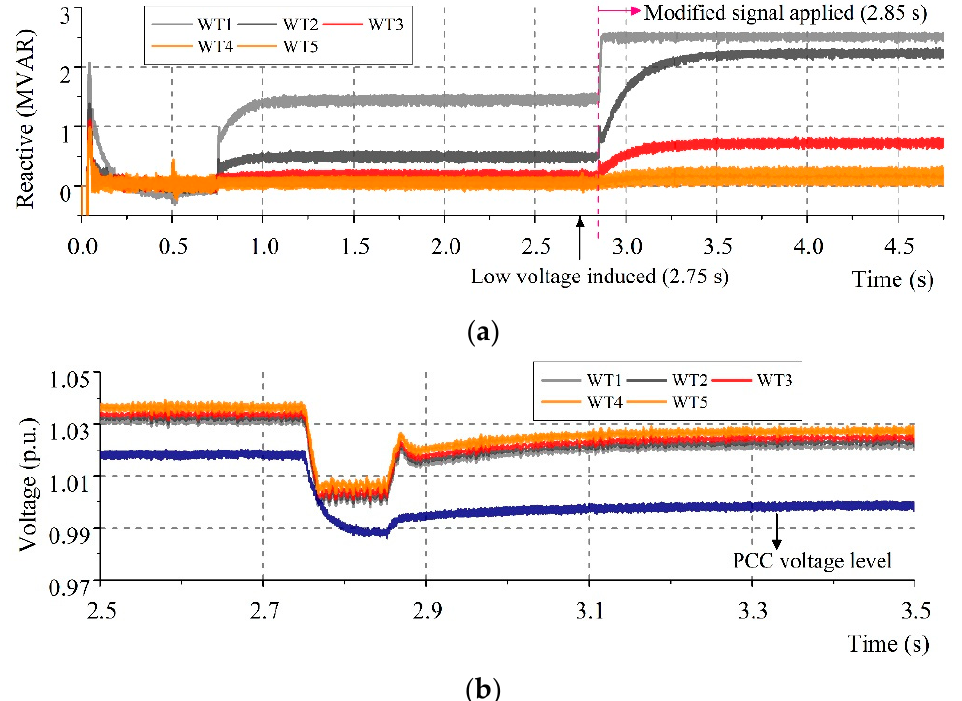
Figure 8. Reactive power supply from array 1 and voltage condition in case A, with ( a ) reactive power supply, and ( b ) voltage variation.